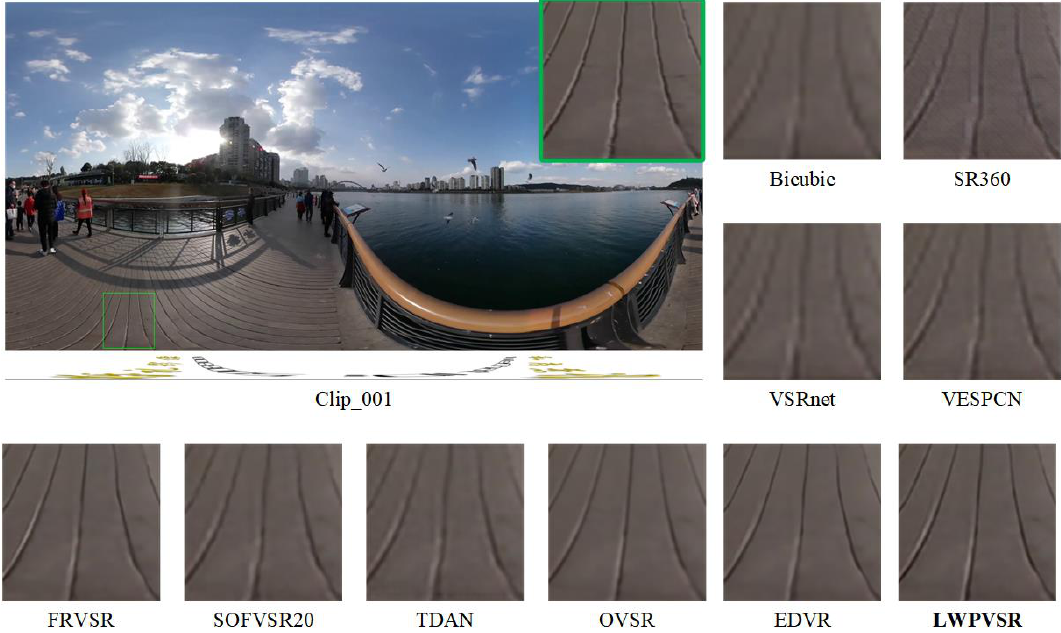
Figure 7. The results of all the algorithms performing 4 × super-resolution on Clip_001 of the MiG test